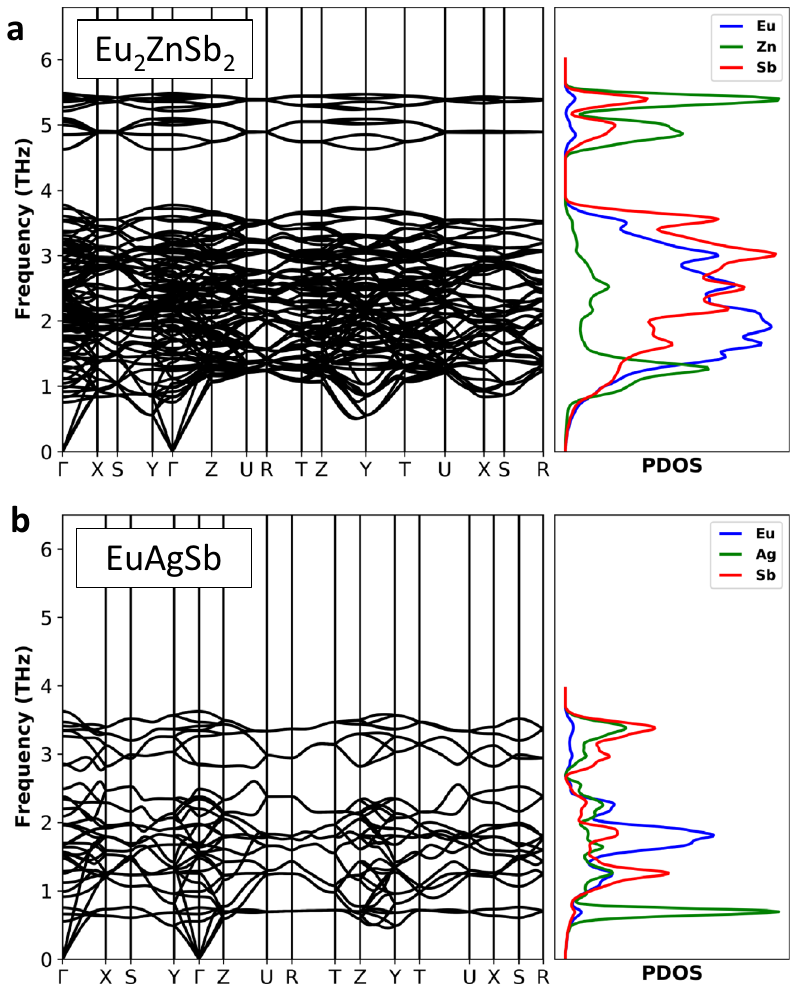
Fig. 4 Calculated phonon dispersion relations and phonon density of states. a Eu 2 ZnSb 2 (zig-zag structure). b EuAgSb.